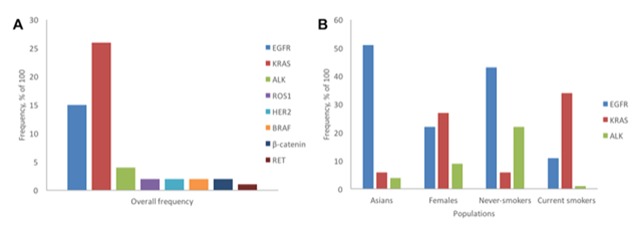
Frequencies of common driver mutations in lung adenocarcinoma in the US and Europe. By overall frequency (A) and population group (B). Data are derived from large clinicopathologic cohort studies published since 2008 and are representative of US and European populations.